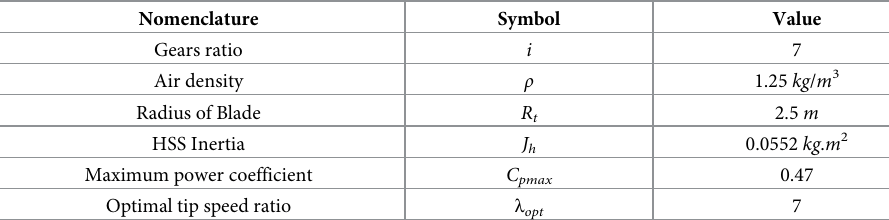
Table 2. Parameters of wind